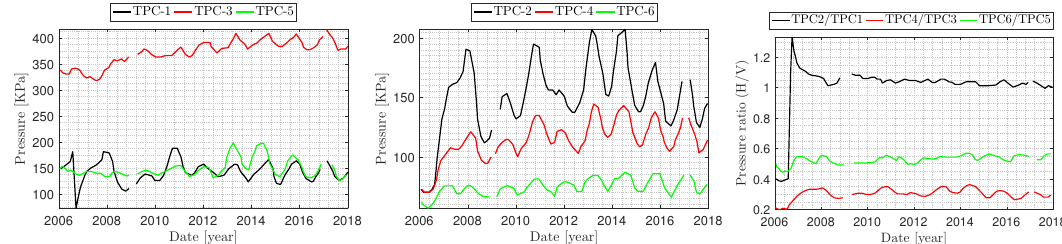
Figure 9. Variation of total pressure in Section #4.